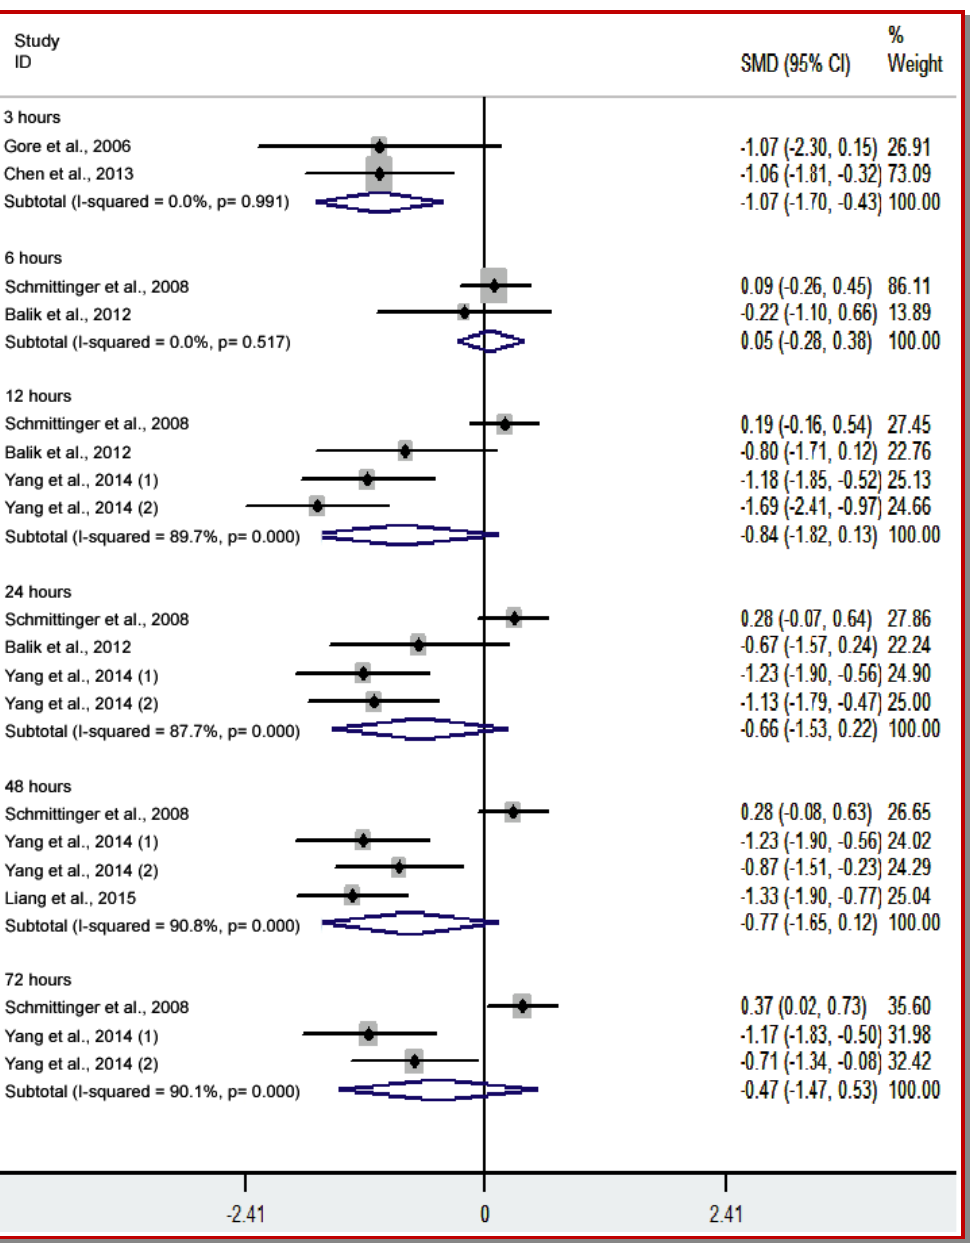
Figure 6: Meta-analysis of beta-blocker on the cardiac index (digit within the parenthesis means the number of studies for compar- ison) Previous study has suggested that patients with severe sepsis who have taken beta-blockers for a long time before admission have a better clinical prognosis than those who have not taken beta-blockers (Macchia et al., 2012). Seven studies included in this study reported 28- day mortality, and analysis showed that beta-blockers can effectively reduce 28-day mortality in patients with sepsis. This study confirmed that beta-blockers can significantly improve the clinical prognosis of patients with